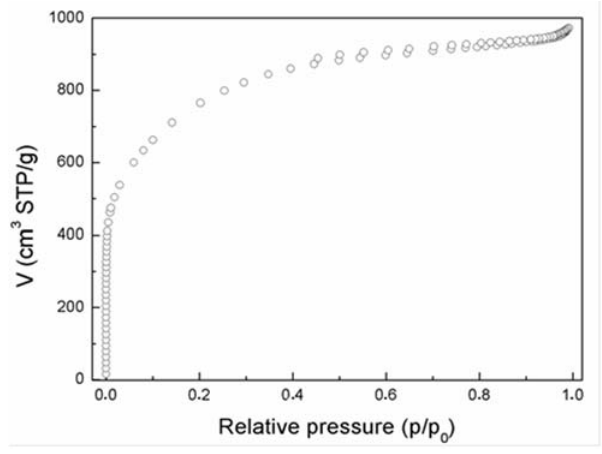
Figure 4. Nitrogen adsorption-desorption isotherms for the activated carbon. Table 2. Porosity features of the activated carbon.